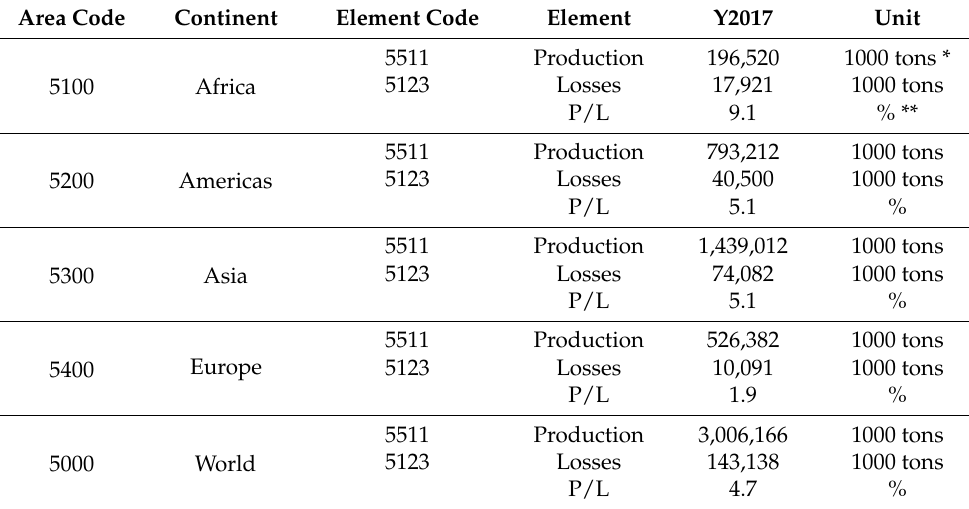
Table 4. Proportion of produced and lost cereals (excluding beer—item code: 2905), 2017. Data source: FAOSTAT [39], edited by